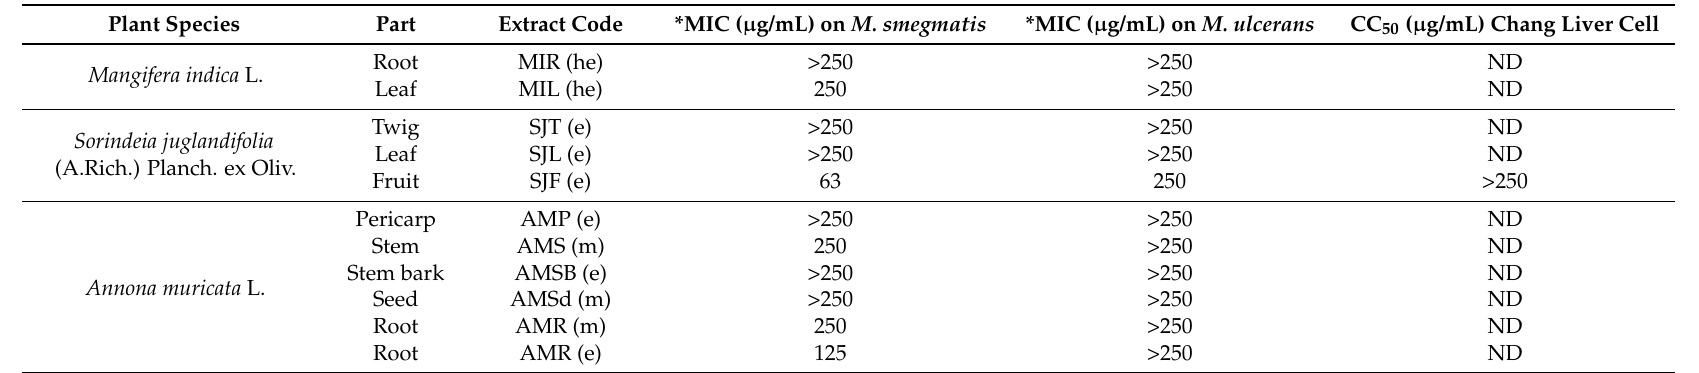
Table 2. Antimycobacteral activity of the plant